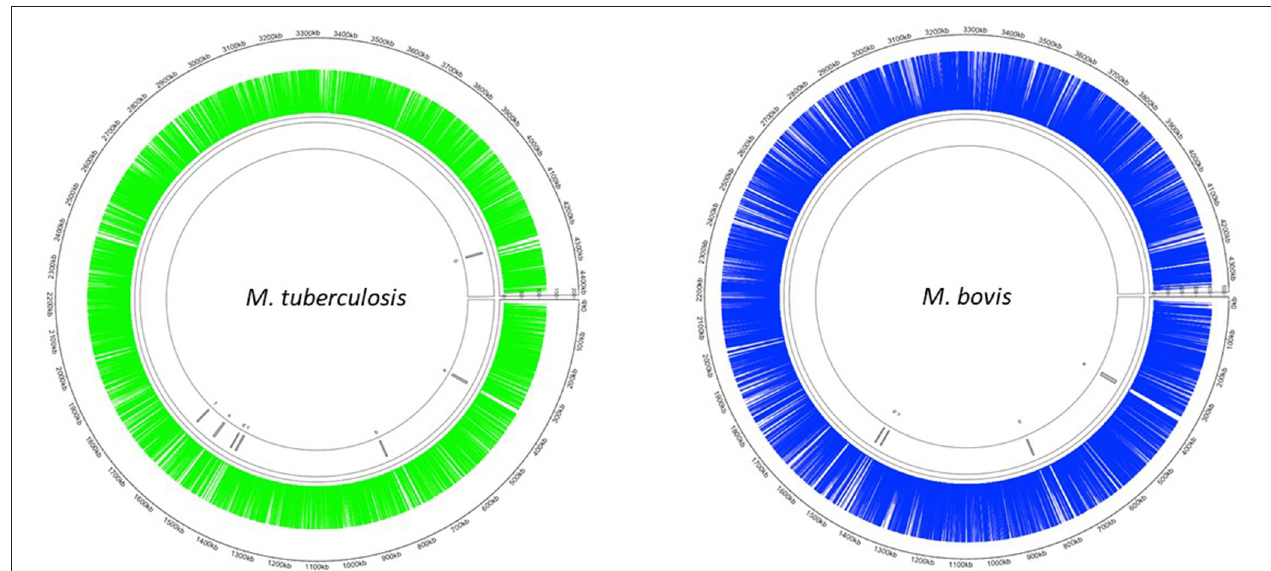
FIGURE 1 | Distribution of Tn insertions in both M. tuberculosis and M. bovis. Transposon libraries were created in M. tuberculosis and M. bovis using the Himar1 system and sequenced on a HiSeq NGS platform (Illumina, UK) as described in the materials and methods. Insertion locations of Himar1 across the M. tuberculosis genome (green) and M. bovis genome (blue) were visualised using Circlize (41).